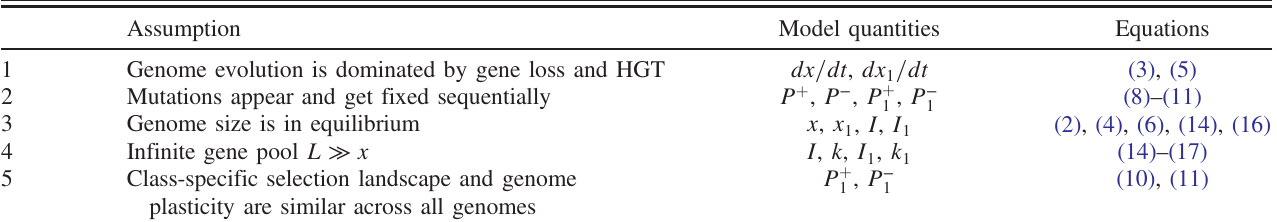
TABLE III. Summary of model